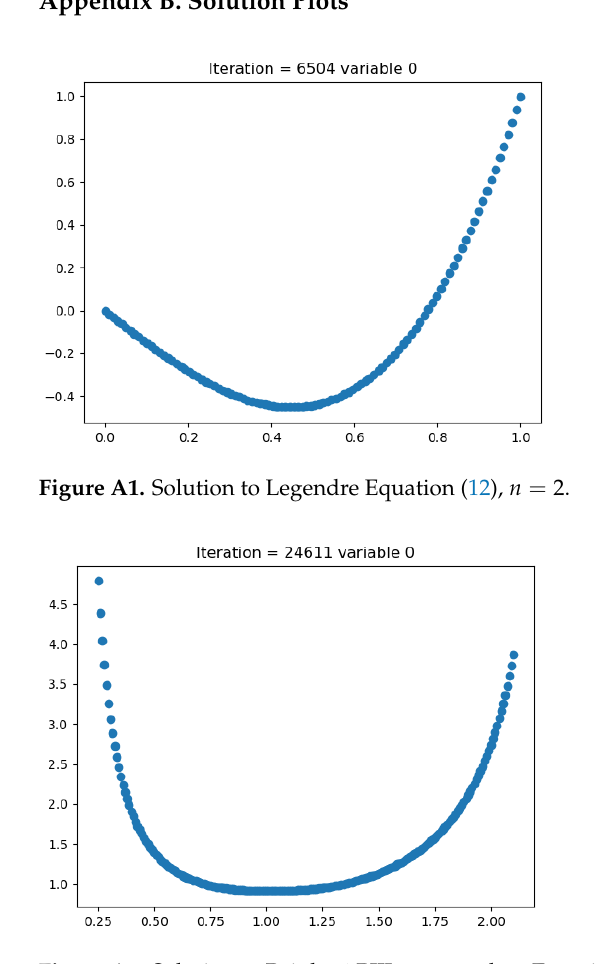
Figure A2. Solution to Painlevé PIII transcendent Equation (A3).